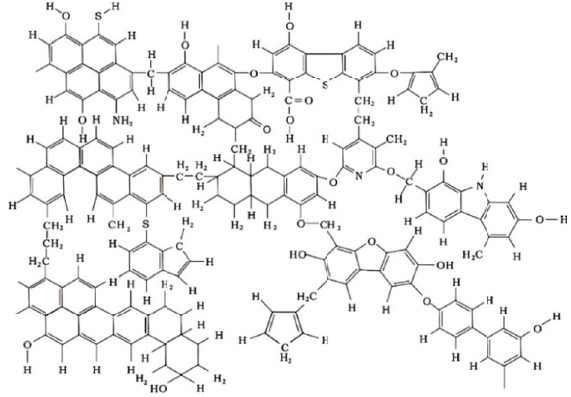
Figure 1: Molecular plane structure of the Wiser model [28].